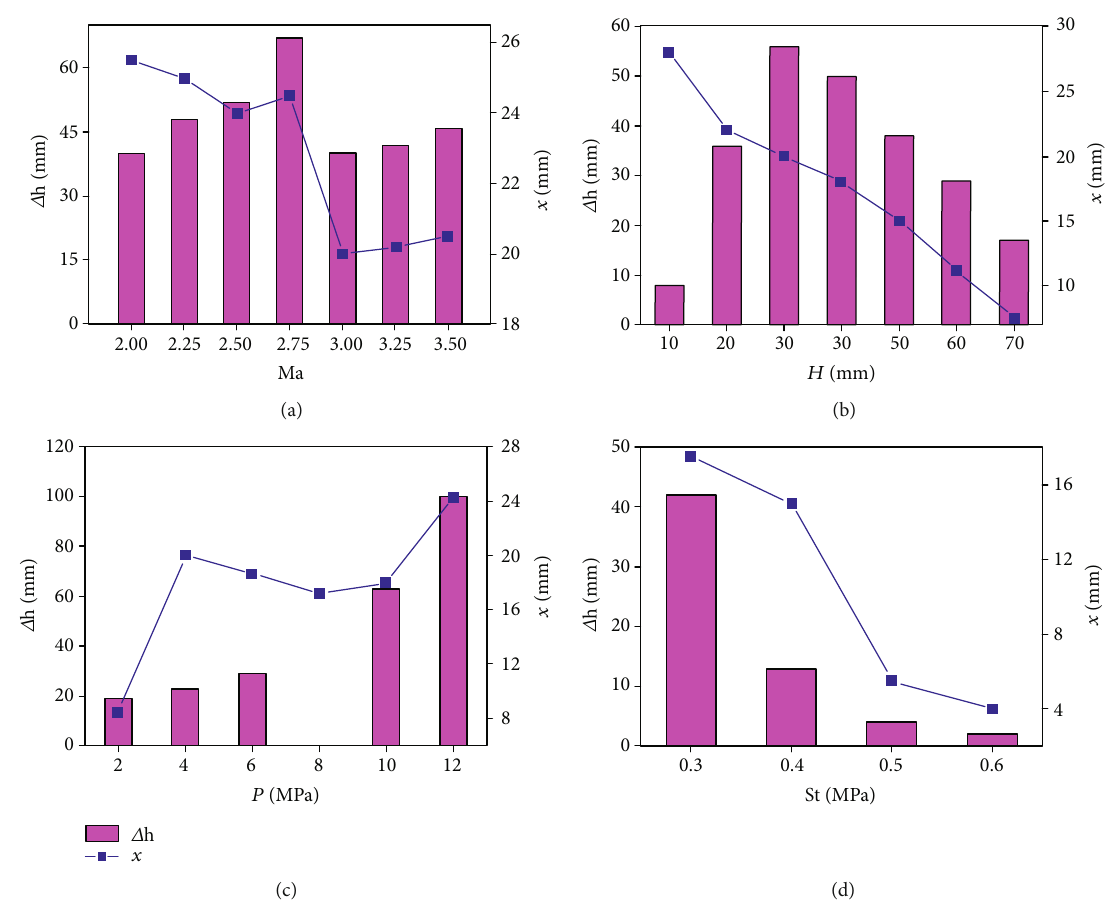
Figure 11: Variation of depth and radius of an erosion pit with di ff erent jet parameters (Ma, H , P , S